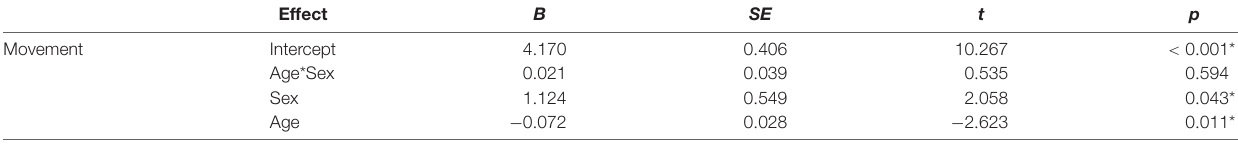
TABLE 3 | The effects of age, sex, and their interactions on head movement (groups combined).